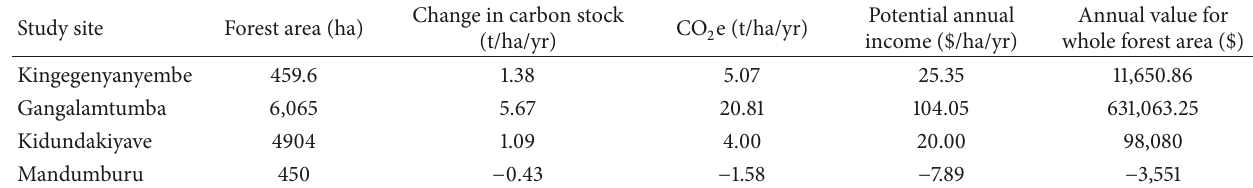
Table 6: Forest area and its potential gross annual income from avoided CO 2 e